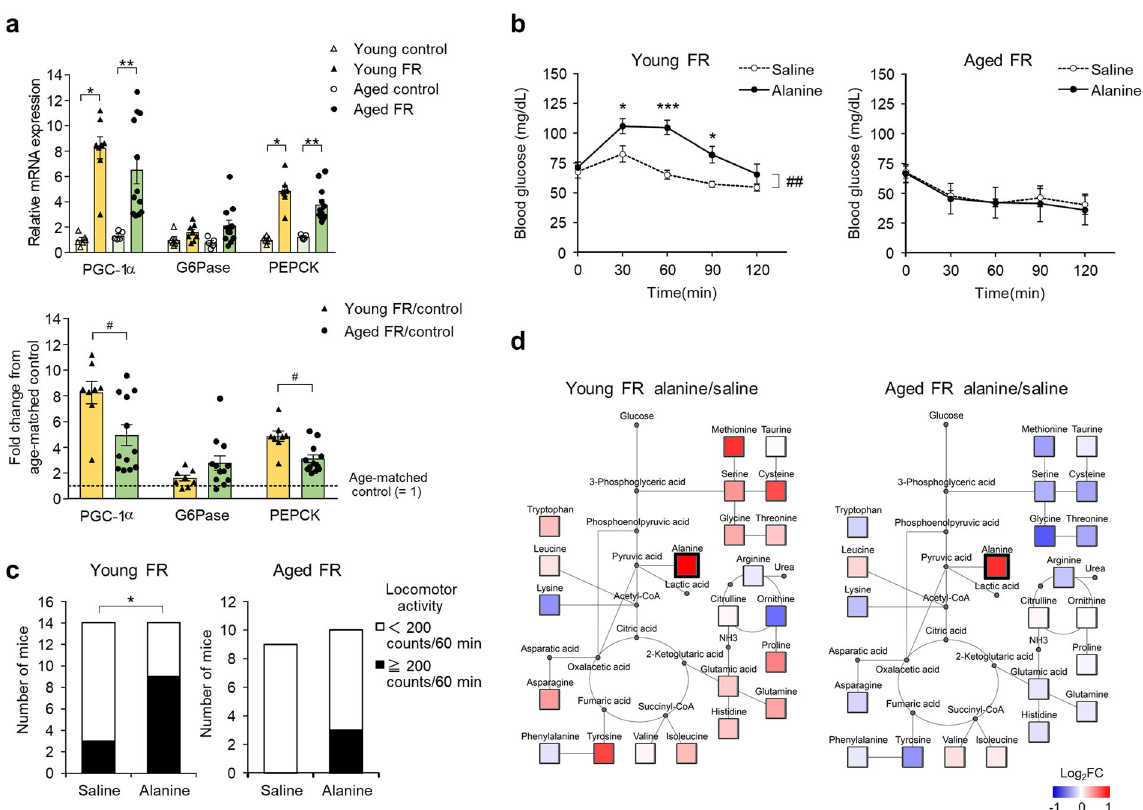
Fig. 4 Metabolic differences between young and aged food-restricted mice. a Hepatic gene expression in young and aged food-restricted (FR) mice. * P < 0.05, ** P < 0.01 by the Steel – Dwass (upper panel) or # P < 0.05 by Mann – Whitney (lower panel) test, young control ( n = 6), young FR ( n = 8), aged control ( n = 5), and aged FR ( n = 12). b Changes in blood glucose levels in young (left) and aged (right) FR mice after alanine injection. In the young mice, two-way repeated-measures ANOVA revealed signi fi cant effects of the drug (##; F (1, 8) = 12.8, P = 0.0072), time ( F (4, 32) = 18.9, P < 0.001), and the drug × time interaction ( F (4, 32) = 4.82, P = 0.0037). * P < 0.05, *** P < 0.001 vs. saline-treated mice at each time point by Bonferroni test; n = 5 mice. In the aged mice, two-way repeated measures of ANOVA revealed the signi fi cant effect of time ( F (4, 24) = 8.92, P < 0.001), n = 4. c The proportions of mice divided by the degree of locomotor activity between 60 and120 min after alanine injection. * P < 0.05 by chi-square test; young FR saline ( n = 14), young FR alanine ( n = 14), aged FR saline ( n = 9), and aged FR alanine ( n = 10). d Amino acid metabolic pathway map in young and aged mice subjected to FR at 180 min after alanine injection. Mean ratio of plasma amino acid levels detected in alanine-treated mice to saline-treated mice is shown according to the color scale. Red color represents upregulation and blue color represents downregulation compared to the mean values of age-matched saline-treated mice. Undetected amino acids and key metabolites are shown with small gray circles. Data are presented as mean ± SEM ( a , b